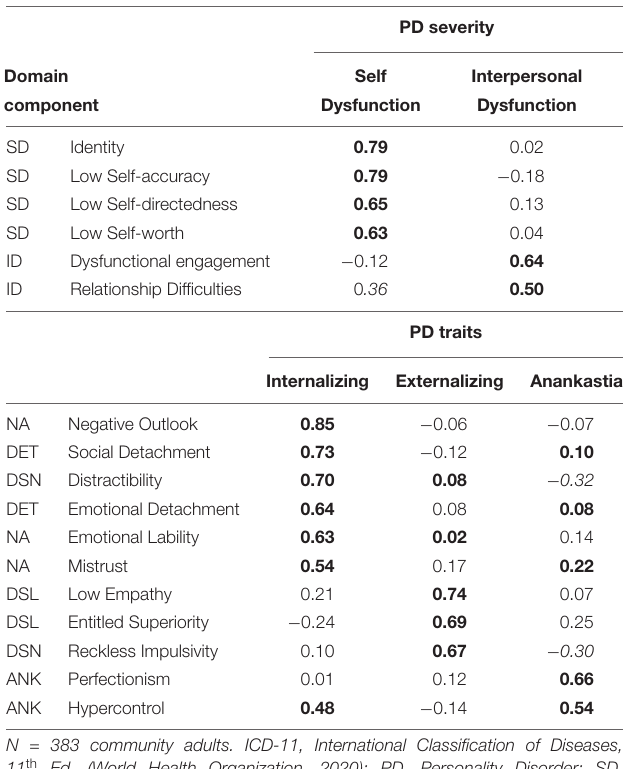
TABLE 7 | Promax-rotated three-factor principal axis factor analysis of ICD-11 personality disorder-severity and trait component